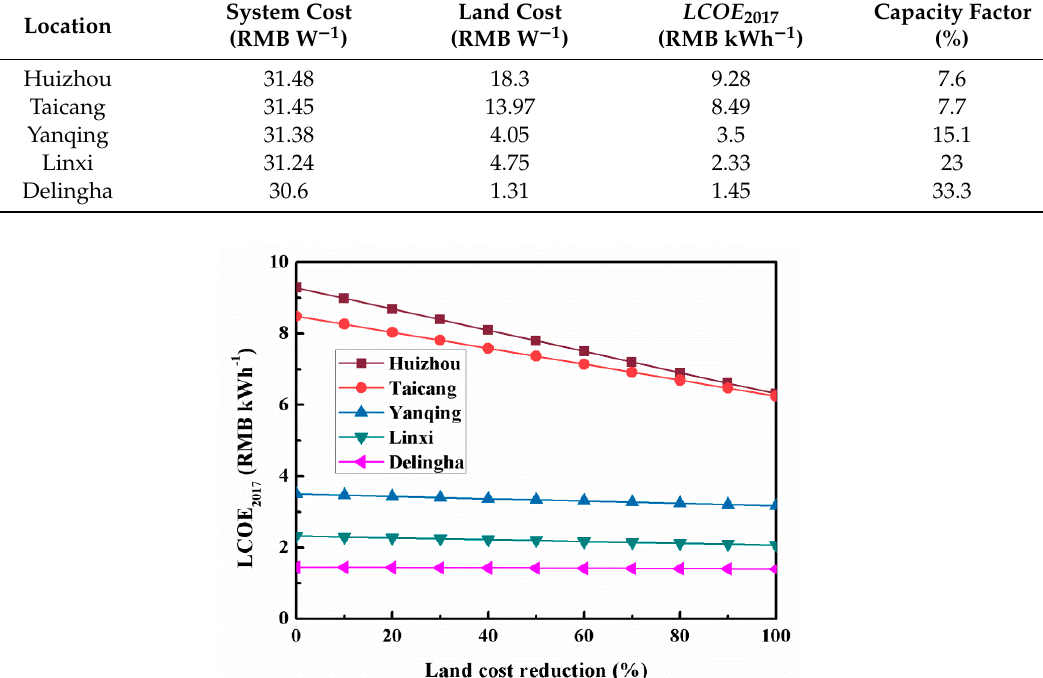
Table 6. Thermal properties and thermal energy storage (TES) costs of selected molten-salts. NaNO 3 - Molten-Salt